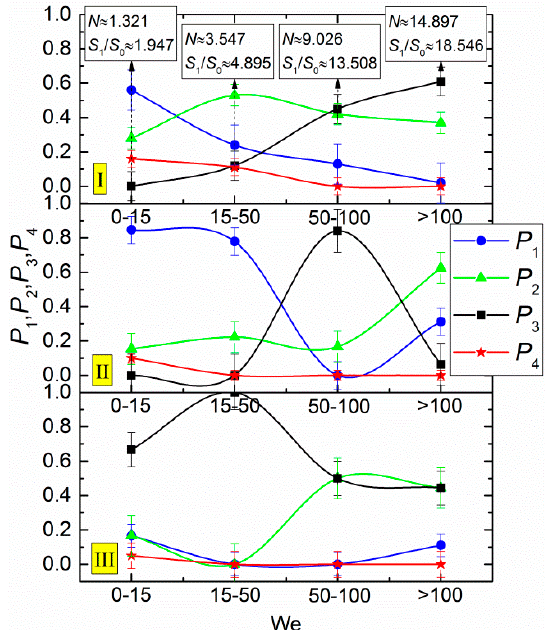
Figure 7. Frequency of each of four droplet interaction modes ( P 1 —coalescence, P 2 —separation, P 3 —disruption, P 4 —bounce) when varying the degree of aerosol flow turbulence: I—Re ≈ 1100: II—Re ≈ 2400; III—Re ≈ 2800.